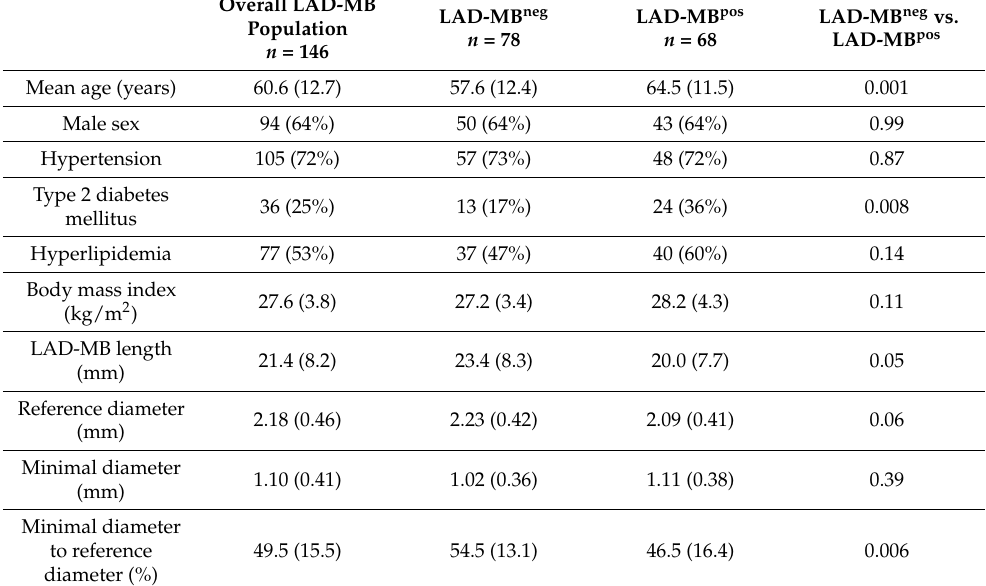
Table 1. The distribution of the data of patients presenting with angina pectoris and with a myocardial bridge detected in the left anterior descendent artery ( n = 146) and comparison of the LAD-MB neg and LAD-MB pos population. Overall LAD-MB LAD-MB neg LAD-MB pos LAD-MB neg Population n = 78 n = 68 n = 146